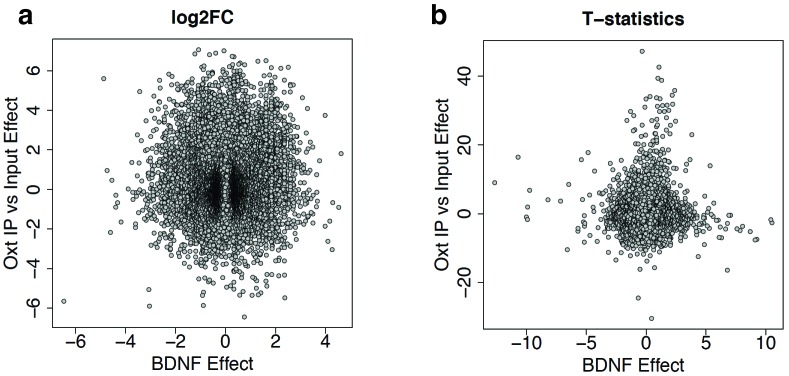
DEGs in Oxt Input vs. Oxt IP do not overlap with DEGs in control IP vs. Bdnf-e1 -/-IP.(a) Plot depicting log2 fold changes of DEGs in Oxt IP vs. Oxt Input compared to the log2 fold changes of DEGs in control IP vs. Bdnf-e1 -/- IP. As expected, there is no correlation between the two sets of DEGs. (b) Plot depicting t-statistics for Oxt IP vs. Oxt Input compared to t-statistics for control IP vs. Bdnf-e1 -/- IP.